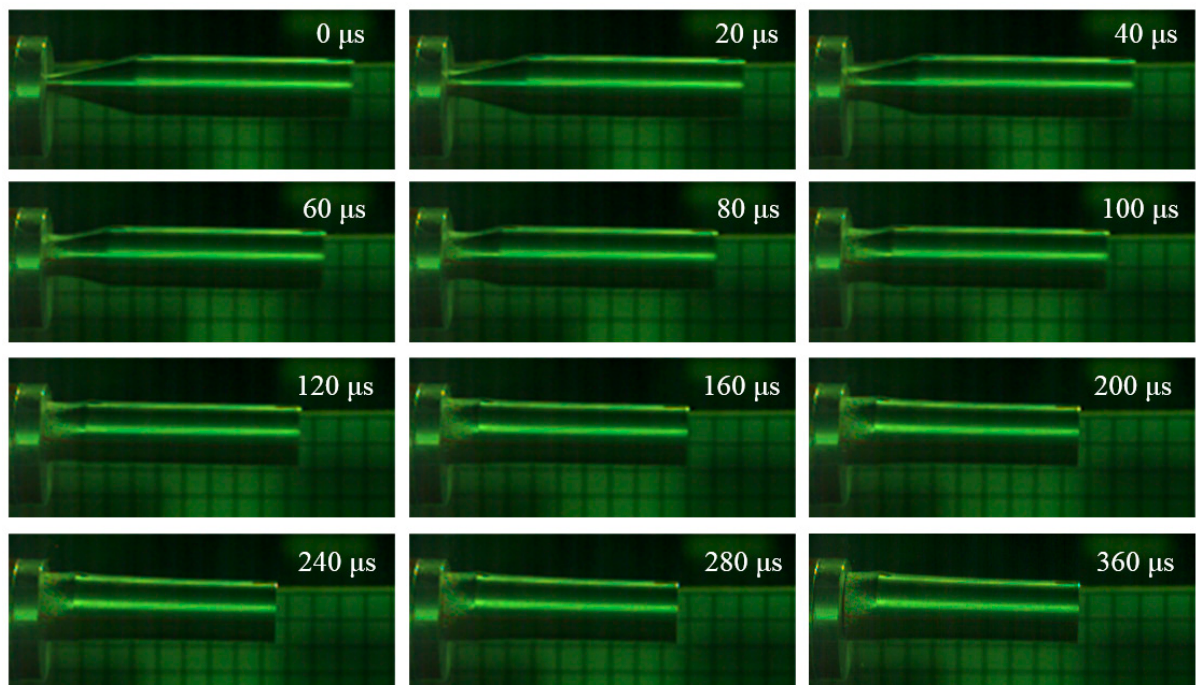
Figure 10. Series of high-speed photographs of the Taylor impact of the truncated conical projectable (168 m/s).